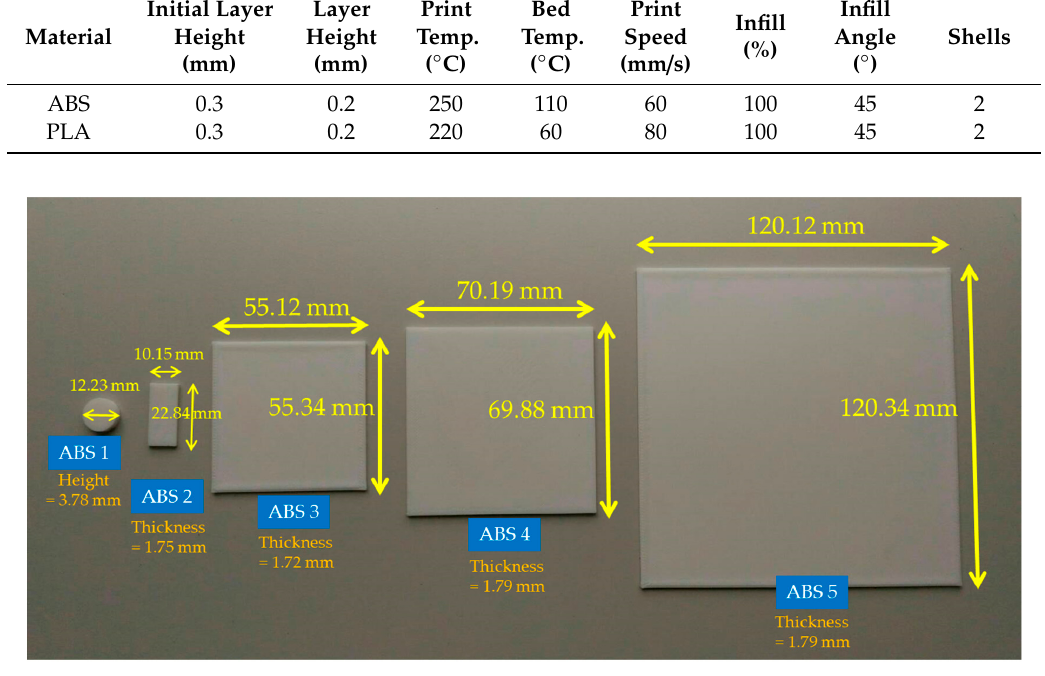
Figure 9. Five printed ABS MUTs for characterization.